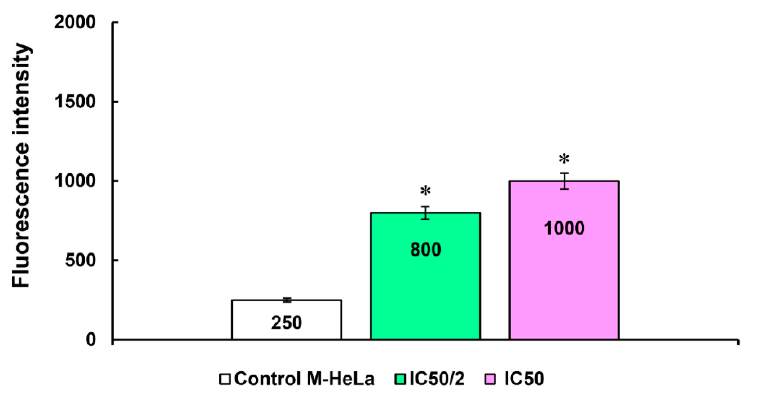
Figure 13. Induction of ROS production by compound 7 . 1—at concentration IC 50 /2 (6 μ M); 2—at concentration IC 50 (12 μ M). * Values indicate p < 0.05. concentration IC 50 (12 µ M). * Values indicate p <